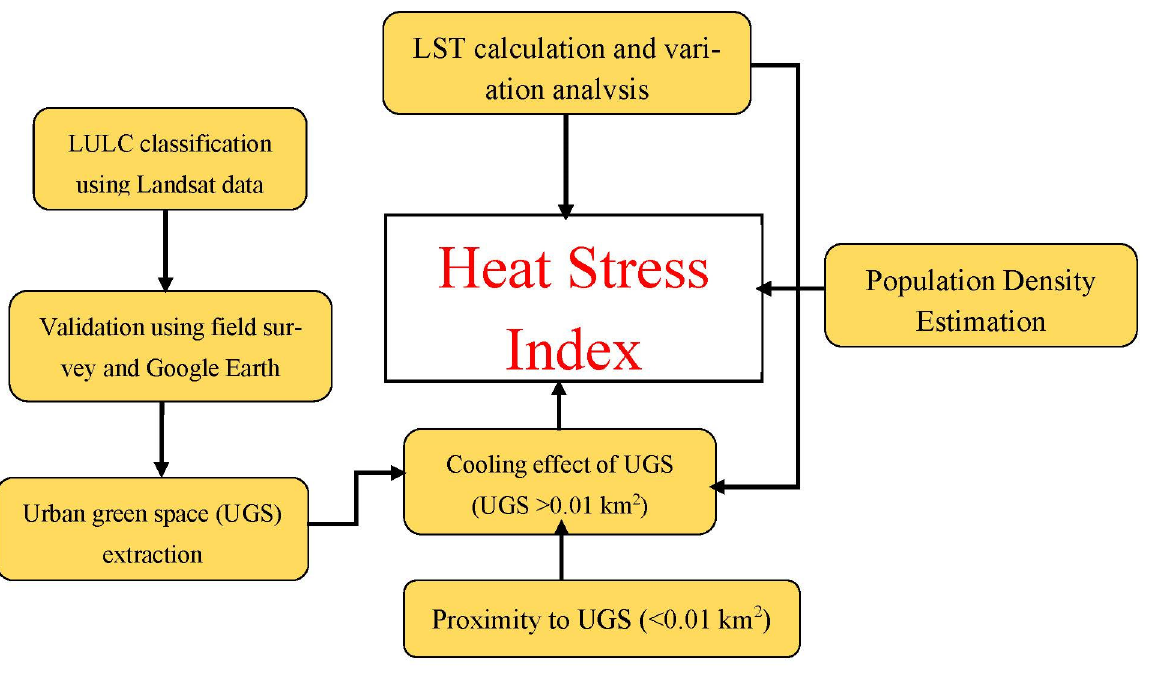
Figure 4. Adopted methodology for heat stress index calculation.